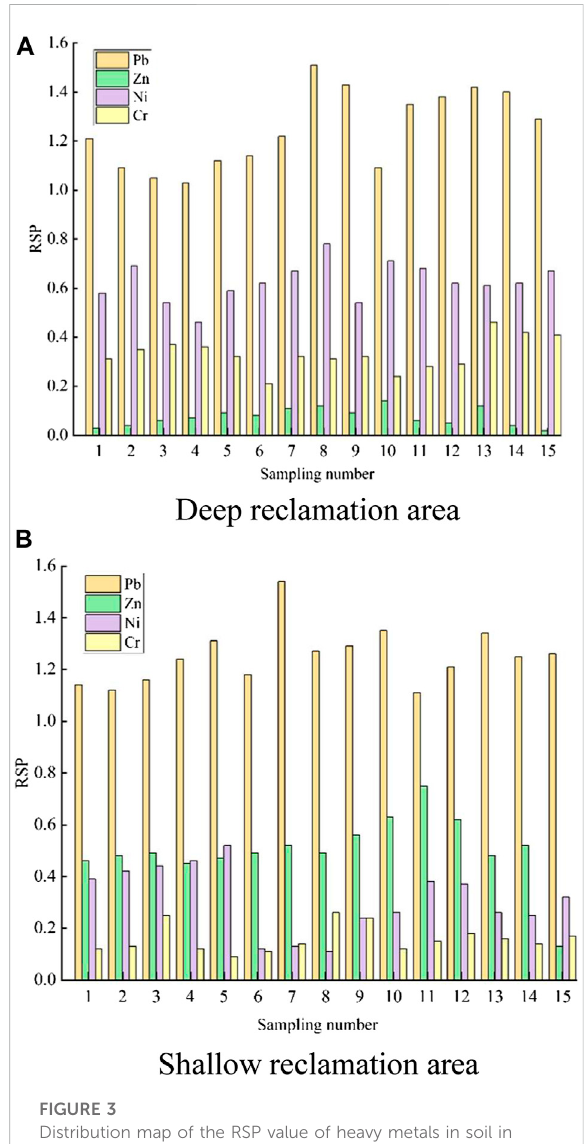
FIGURE 3 Distribution map of the RSP value of heavy metals in soil in deepandshallowreclamationareas. (A) Deepreclamationarea. (B) Shallow reclamation